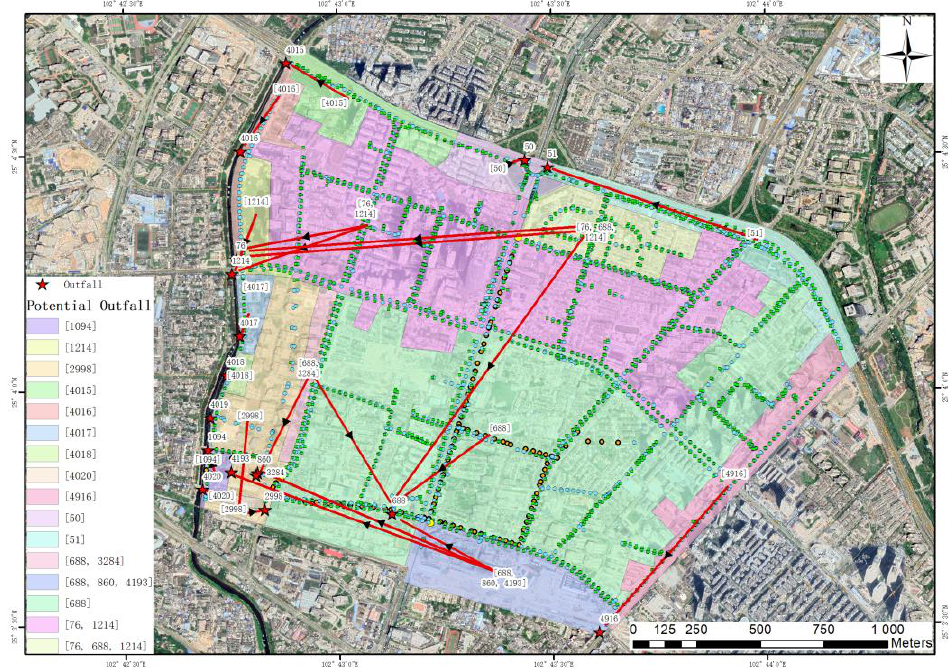
Figure 8. Subcatchment based on potential outfall in Maxiangou catchment.